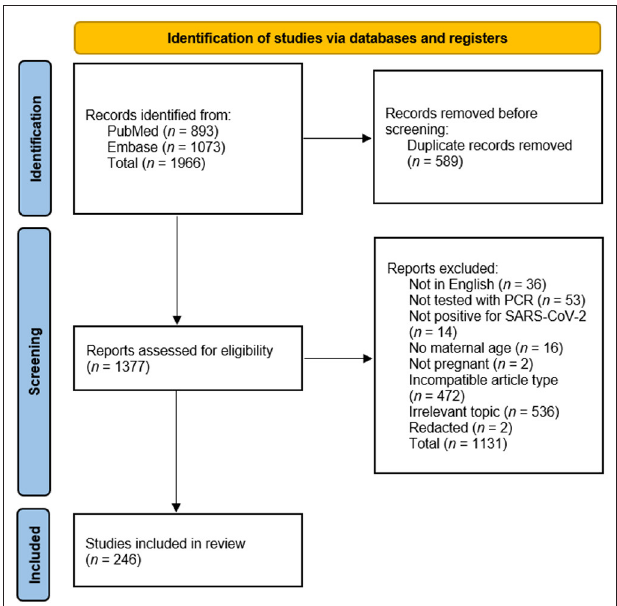
FIGURE 1 | Study selection flowchart.